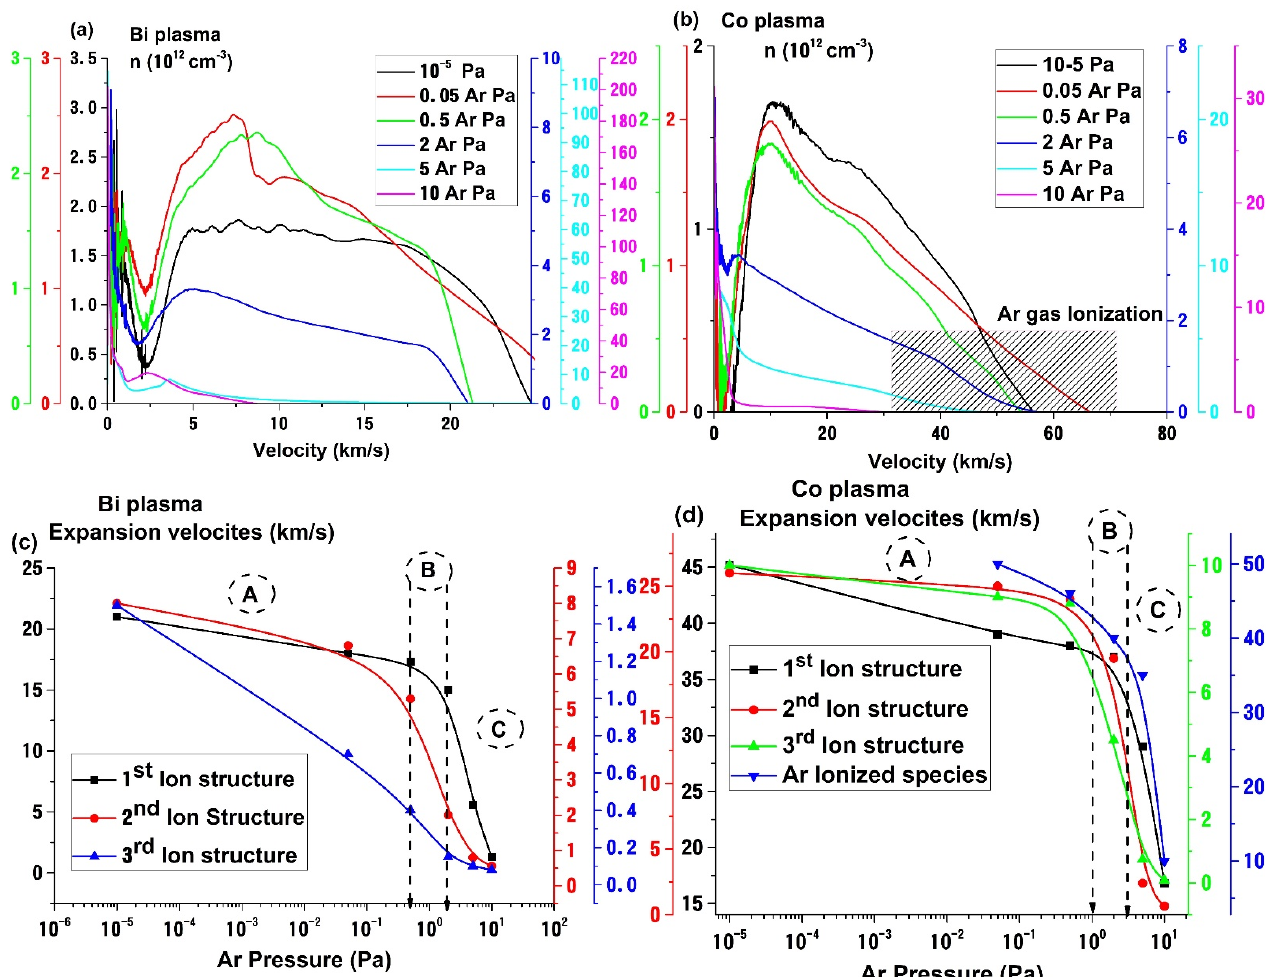
Figure 3. Pressure effect on Bi ( a ) and Co ( b ) ion velocity distribution and the deconvolution of the Bi ( c ) and Co ( d ) distribution characterizing the plasma expansion at 10 − 5 Pa.